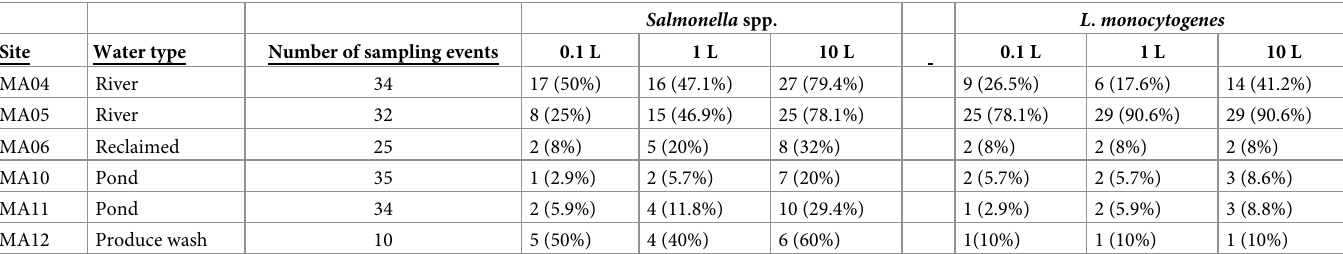
Table 3. Number (percentage) of total sampling events at each site where each water volume filtered contained Salmonella or L . monocytogenes . Salmonella